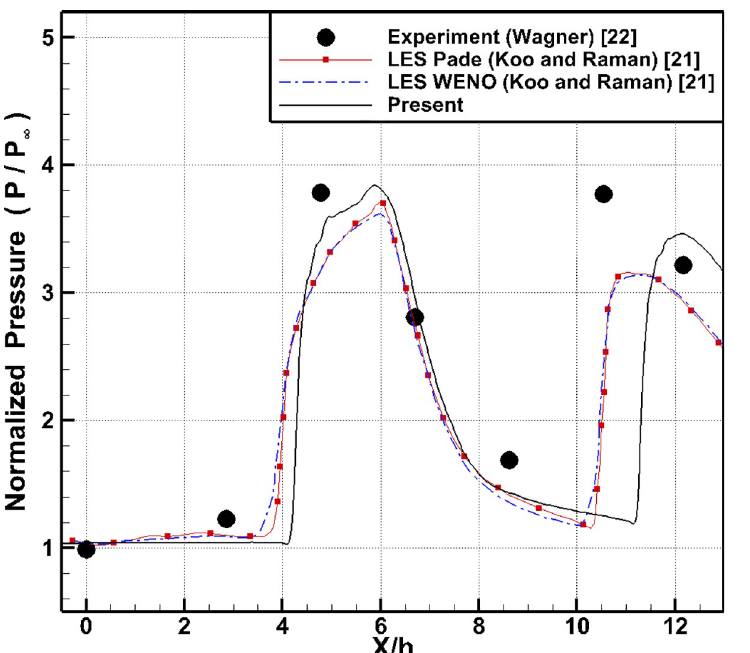
Fig 7. Normalized lower wall pressure distribution of the inlet